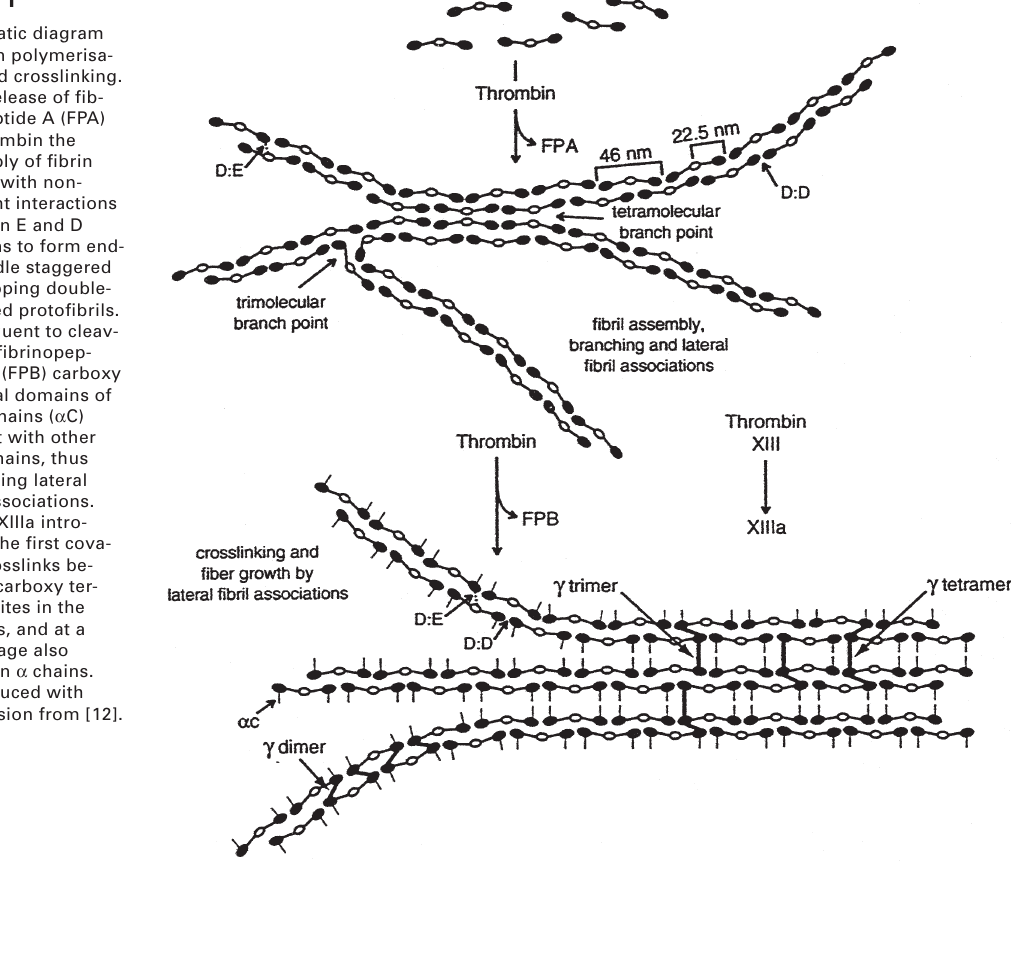
Figure 1 Schematic diagram of fibrin polymerisa- tion and crosslinking. After release of fib- rinopeptide A (FPA) by thrombin the assembly of fibrin begins with non- covalent interactions between E and D domains to form end- to-middle staggered overlapping double- stranded protofibrils. Subsequent to cleav- age of fibrinopep- tides B (FPB) carboxy terminal domains of the a -chains ( a C) interact with other a C domains, thus promoting lateral fibril associations. Factor XIIIa intro- duces the first cova- lent crosslinks be- tween carboxy ter- minal sites in the g chains, and at a later stage also between a chains. Reproduced with permission from